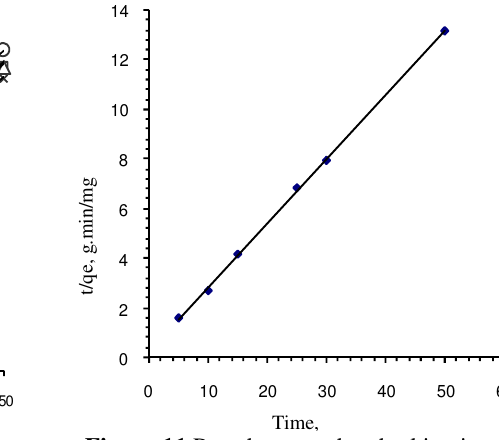
Figure 10 . Pseudo-second-order kinetics for the adsorption of Cr(VI) 10 mg/L onto MPGP MPGP 2 g/L, pH 2